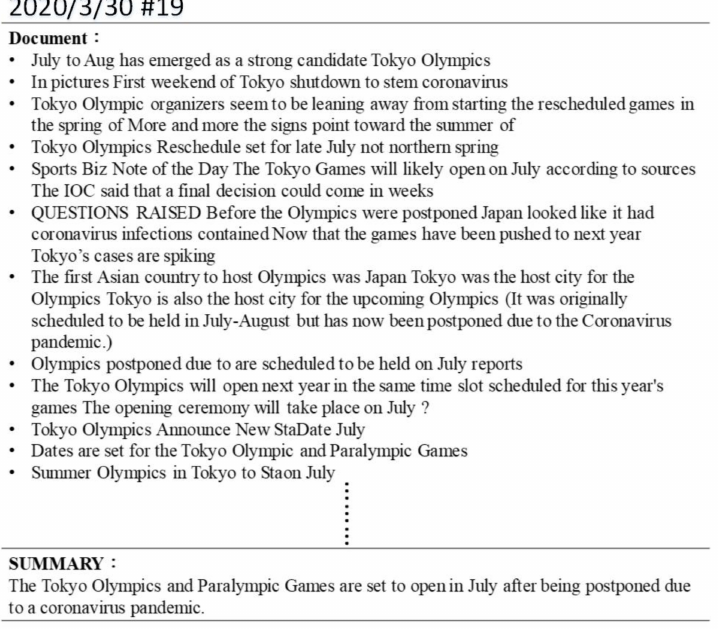
Figure A6. A sample resulting summary of formulated event topics (30 March 2020).